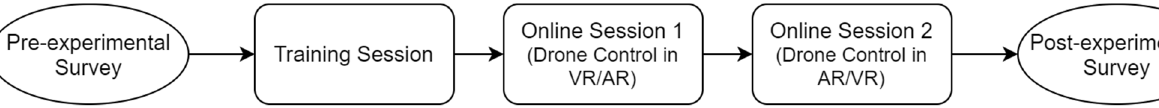
Figure 6. Experimental procedure. Half of the participants engaged in the online sessions in the order of AR followed by VR and the other half engaged in the order of VR followed by AR.